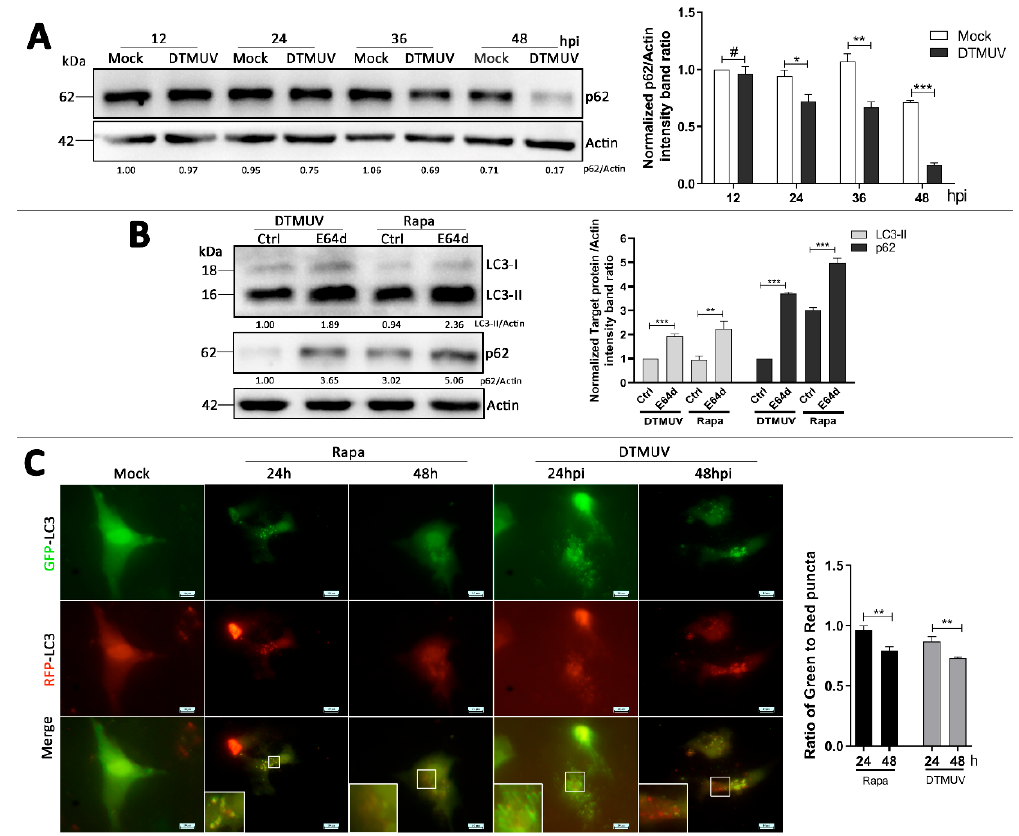
Figure 3. Measurement of the autophagic flux in DTMUV-infected cells. ( A ) DEF cells were mock-infected or infected with DTMUV at an MOI of 1 for 12, 24, 36, and 48 h. Samples were harvested for Western blot analysis and immunoblotted for p62 and β -actin. The ratio of p62 to β -actin was normalized to control conditions in mock-infected cells at 12 h. ( B ) DEF cells were infected with DTMUV CQW1 (MOI = 1) in the presence or absence of E64d (10 µ g / mL) for 24 h post-infection (hpi) and 48 hpi. DEF cells were subjected to a 1-h absorption period of DTMUV and further cultured in fresh medium in the absence (Ctrl) or presence (E64d) of E64d (10 µ g / mL) for 48 hpi. Rapa-treated cells were used as controls. Samples were harvested for Western blot analysis and immunoblotted for LC3, p62, and β -actin. The ratios of targeting proteins to β -actin were normalized to control conditions in the absence of E64d. ( C ) DEF cells were transfected with ptf-LC3 plasmids for 24 h prior to the experiment. Then, cells were mock-infected, Rapa-treated, or infected with DTMUV at an MOI of 1 for 24 hpi and 48 hpi. Cells were fixed and imaged for the fluorescence of GFP and red fluorescent protein (RFP). Images shown were representative of three independent experiments. Ratio of green to red puncta per cell in each group were quantified and obtained from 50 cells undergoing each treatment. Error bars: Mean ± SD of three independent experiments. Two-tailed Student’s t test; # p > 0.05, * p < 0.05, ** p < 0.01, *** p < 0.001.